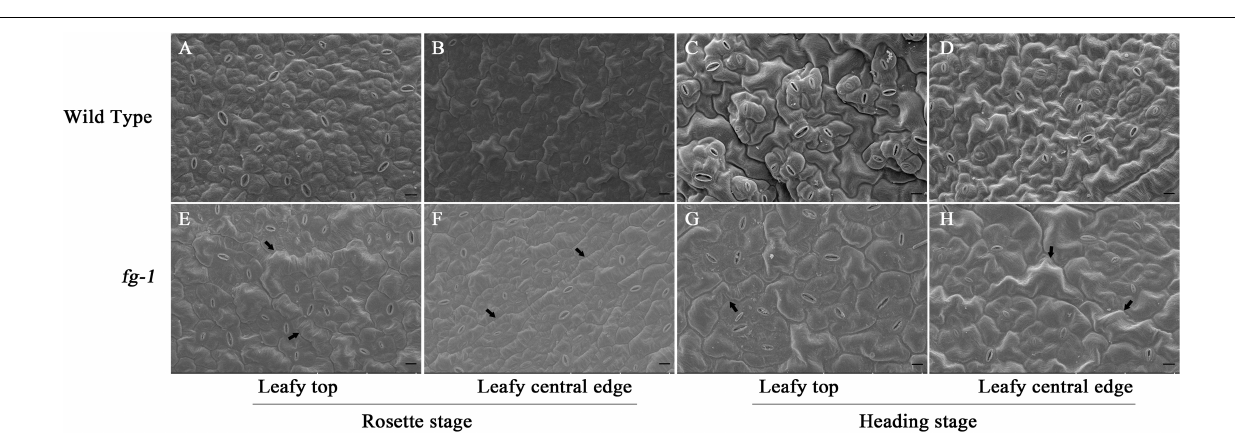
FIGURE 2 | Scanning electron microscopy for abaxial epidermis cells of leaf sections at different developmental stages for the wild type and fg-1 . (A,B) represent abaxial epidermis cells of the top and central leaf edge at the rosette stage in wild type. (C,D) represent abaxial epidermis cells of the top and central leaf edge at the heading stage in wild type. (E,F) represent abaxial epidermis cells of the top and central leaf edge at the rosette stage in fg-1 . (G,H) represent abaxial epidermis cells of the top and central leaf edge at the heading stage in fg-1. Slender cells are indicated by arrows. Length of black bars is 10 µ